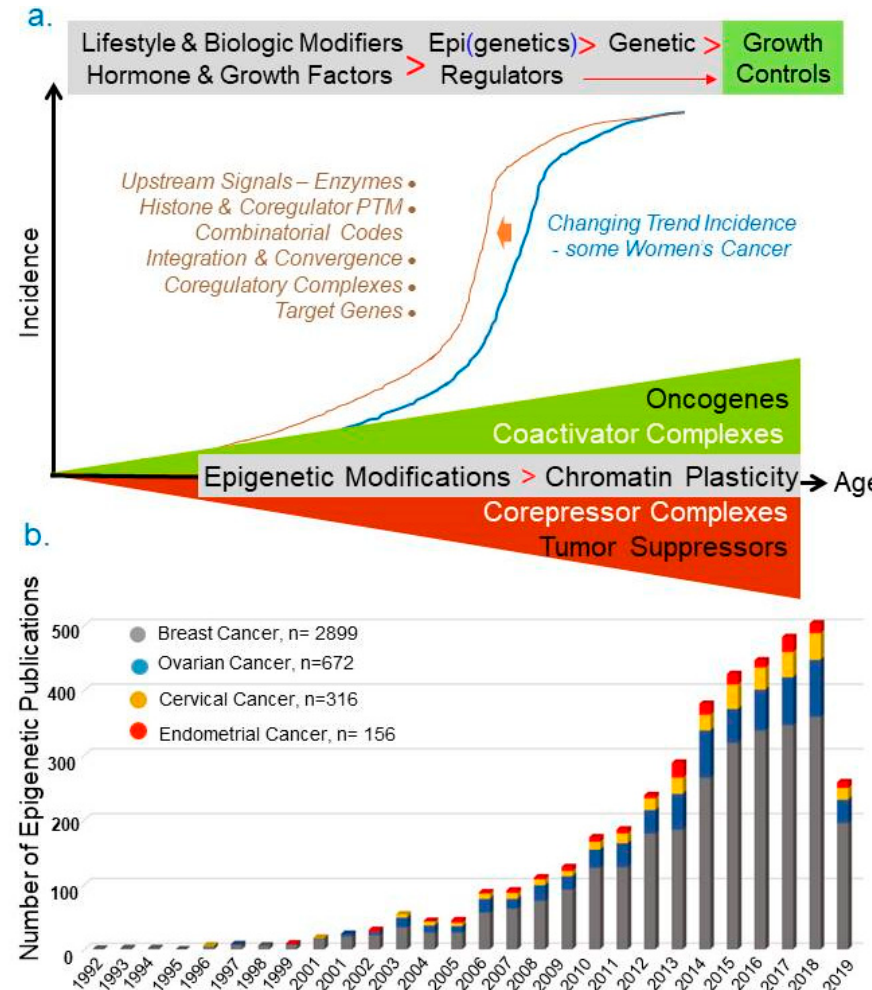
Figure 3. Changing trends in women’s cancer incidence. ( a ) Simplistic view for modifying the growth of cancer cells by epigenetic regulators with or without influencing genetic controls. ( b ) Number of publications for indicated years in PubMed accessed on the 12 th May, 2019, and searched for “epigenetics” and “epigenetic” with “breast cancer”, “ovarian cancer”, “cervical cancer”, or “endometrial cancer” for indicated years.